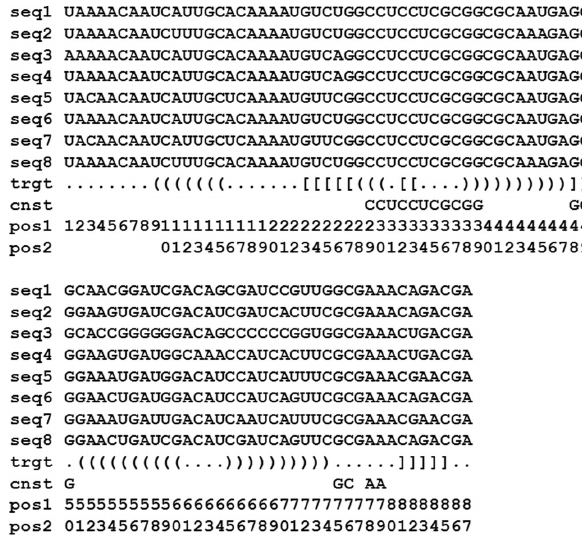
FIGURE 5 | Eight HDV ribozyme sequences designed by MODENA. The top eight rows are designed RNA sequences.Trgt and cnst rows correspond to the target pseudoknotted secondary structure in bracket notation and constraint sequences, respectively. A set of pos1 and pos2 indicates a nucleotide position.